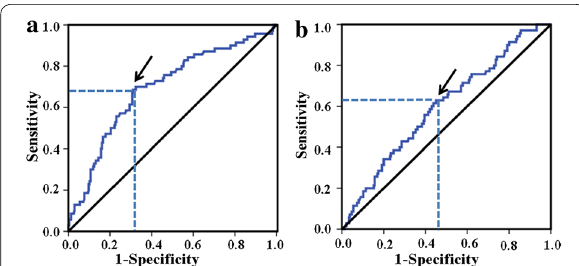
Fig. 1 Receiver operating characteristic curve for the a neutrophil- to-lymphocyte ratio (NLR) and b platelet-to-lymphocyte ratio (PLR). Arrows indicate optimal cutoff